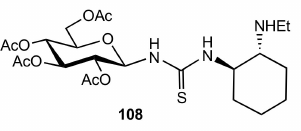
Figure 11. The structure of organocatalyst 108